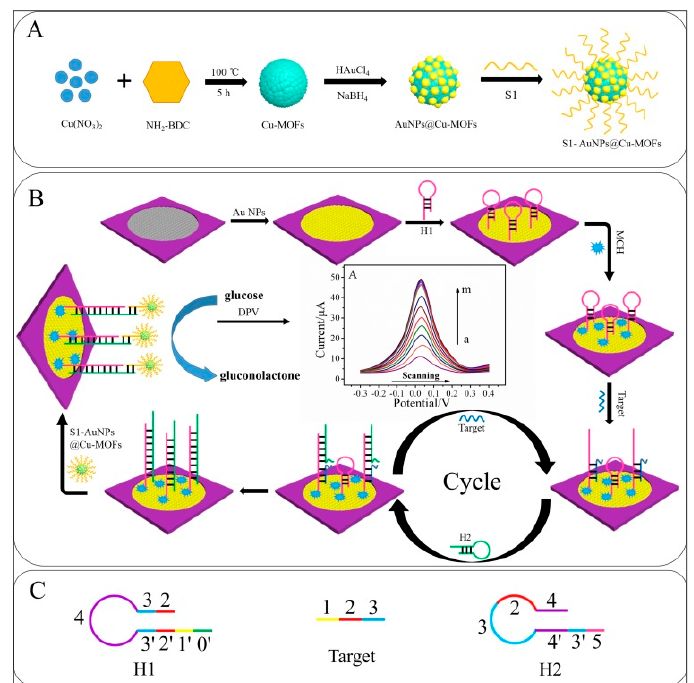
Figure 10. Schematic illustration of the fabrication of the biosensor: ( A ) preparation procedure of S1-AuNPs@Cu-MOFs; ( B ) the detection principle for glucose and the strategy of signal amplification; ( C ) structure of H1, target, and H2 (reproduced with permission from the publisher) [120].